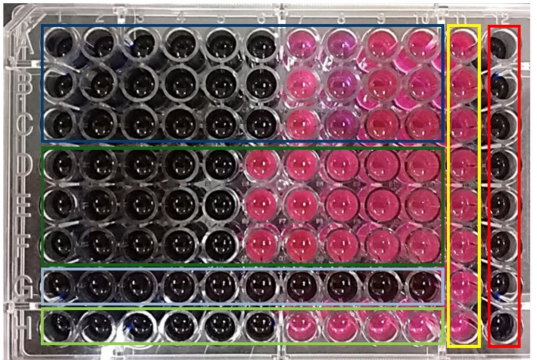
Figure 12. The 96-well plate used in the microdilution assay: the MgO NPs and ceftriaxone antibiotic concentrations decrease from left to right in rows 1 to 10 (8000, 4000, 3000, 2000, 1000, 500, 250, 120, 60, and 30 ppm of MgO NPs). The wells inside the dark blue rectangle correspond to the S. aureus exposed to the MgO NPs, whilst the light blue correspond to the same bacteria exposed to ceftriaxone. The wells inside the dark and light green rectangles correspond to the E. coli exposed to the MgO NPs and the antibiotic, respectively. The yellow rectangle was the growth control, and the red rectangle was the sterility